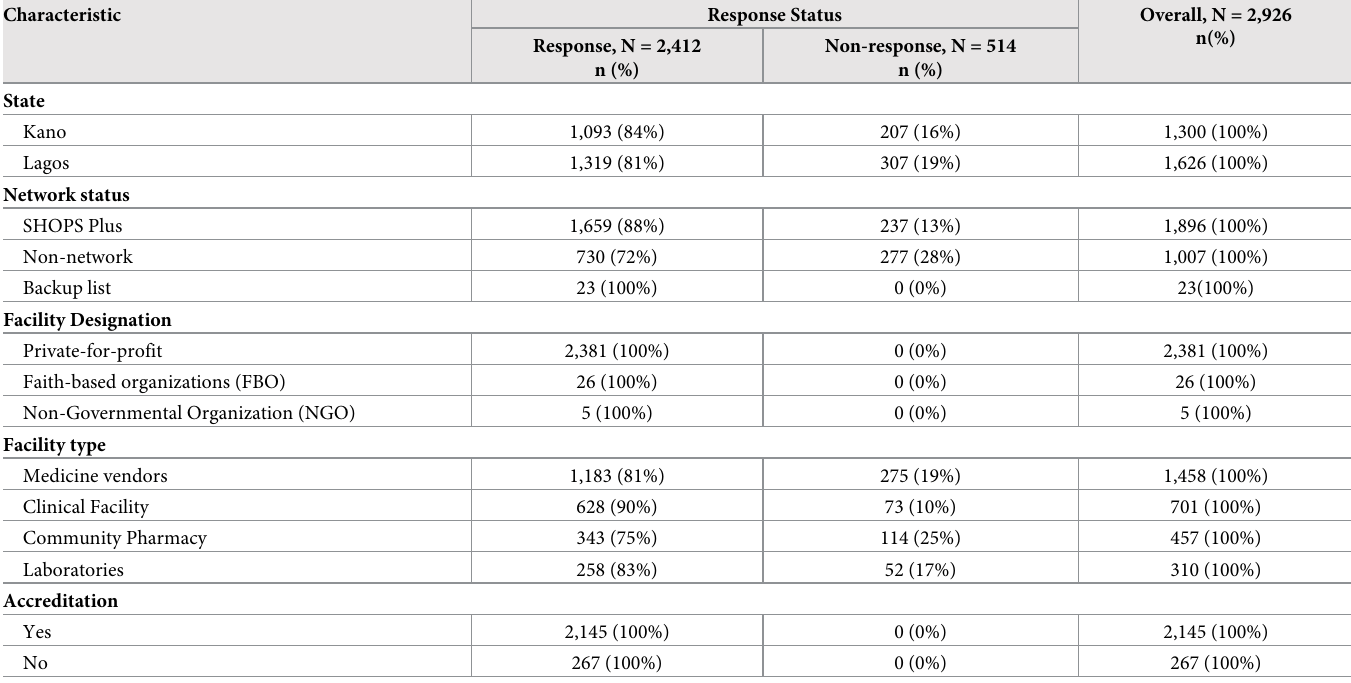
Table 1. Comparison of respondent and non-respondent